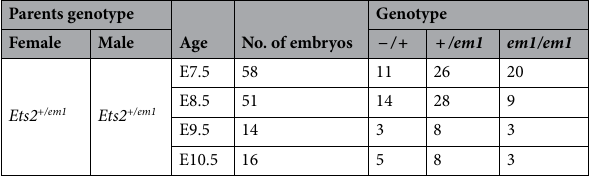
Table 2. Developmental ability of Ets2 mutant